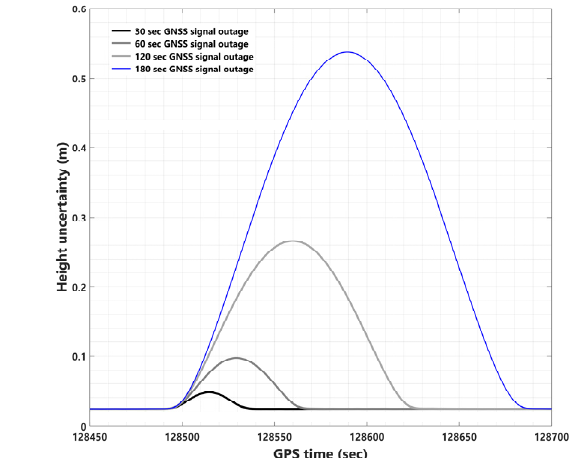
Figure 7. Height uncertainties using smooth processing and assuming different GNSS signal outages.